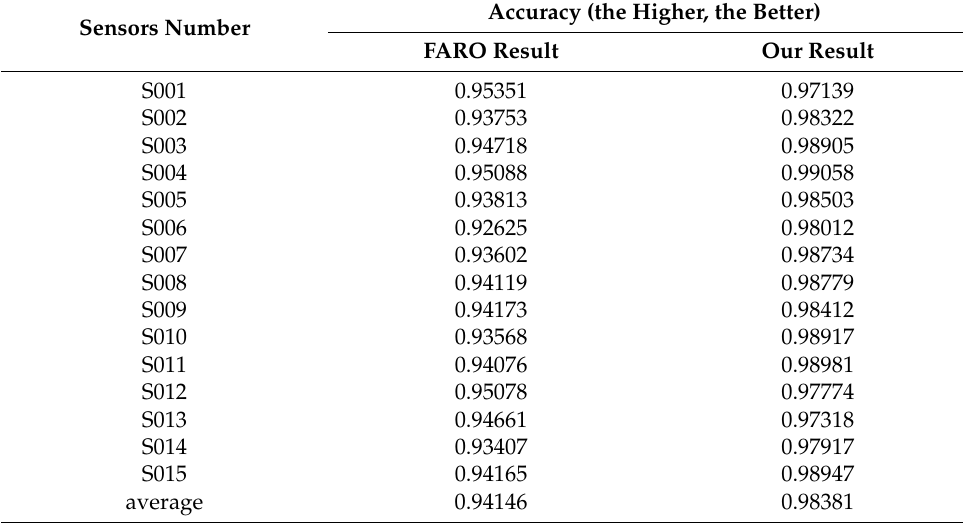
Table 4. Comparison of accuracy performance.